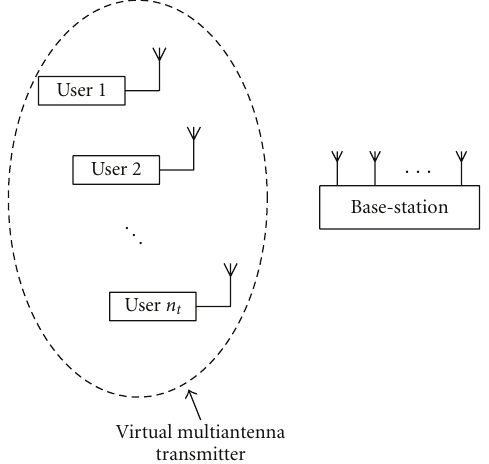
Figure 1: Overview of multiuser MIMO-OFDM